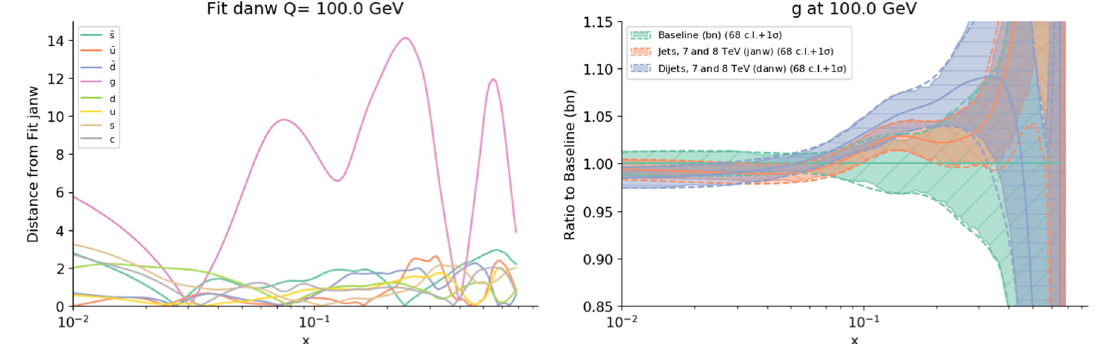
Fig. 16 Same as Fig. 6, but now comparing the fits with all single- inclusive jet data (#janw), and that with all dijet data (#danw) and high- est theory accuracy (NNLO QCD+ EW) and default settings. In the